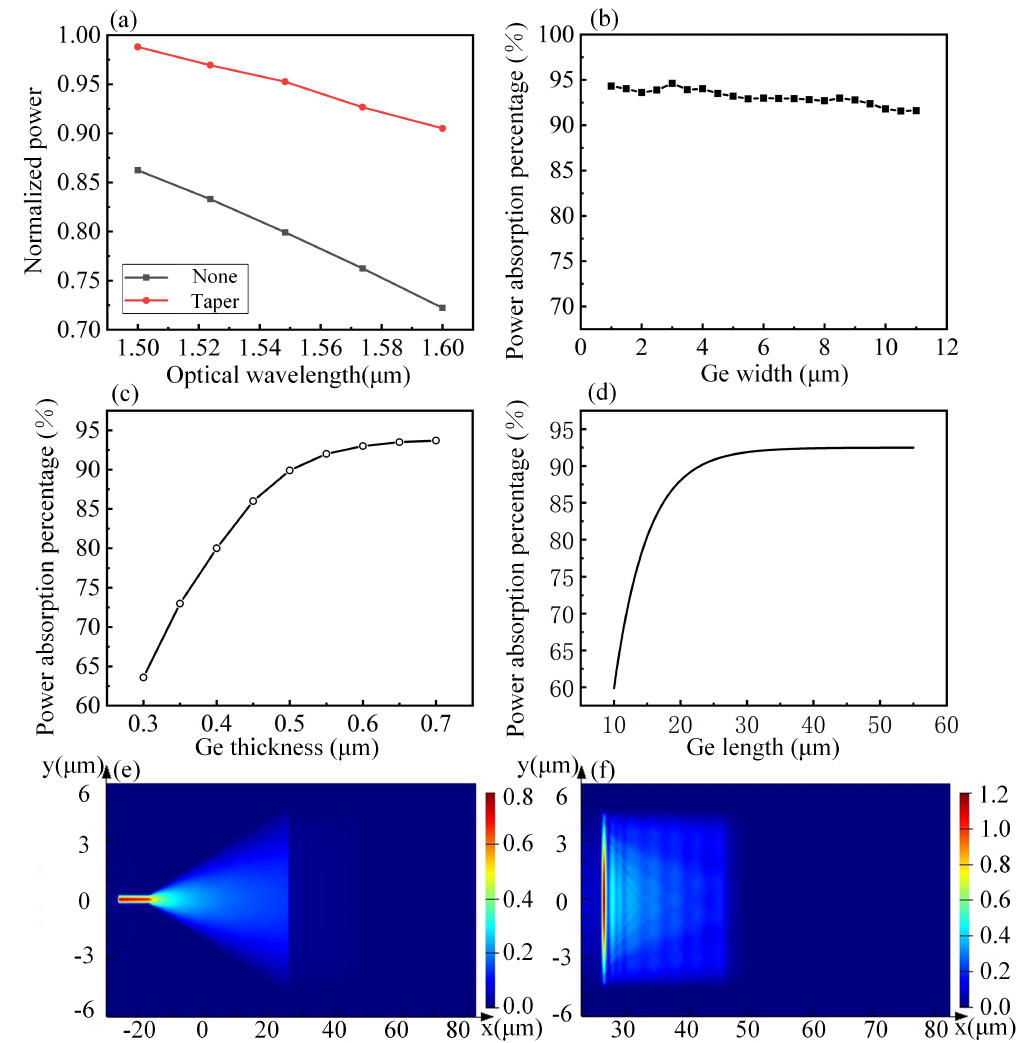
Figure 3. Structural simulation of Ge layer. ( a ) Normalized efficiency of energy transmission without taper structure and Si taper structure. ( b ) Variation curve of the absorption efficiency with Ge layer width. ( c ) Variation curve of the absorption efficiency with Ge layer thickness. ( d ) Variation curve of the absorption efficiency with Ge layer length. ( e ) Optical field distribution of the Si waveguide with a Si–Ge detector. ( f ) Optical field distribution of the Ge waveguide of the Si–Ge detector. The PD structure is designed using the L-edit software, including 10 layers of optical engraving. First layer formed with taper Si waveguide, the second and third layer forming P+ doped region and set up the positive electrode heavily doped P zone formation, the fourth layer forming epitaxial Ge area and is located in the center of Si waveguide, the fifth and sixth layers will form the N+ doped region and set up the negative electrode form heavily doped N area, the seventh and eighth layer metal contact hole filling metal tungsten formation, the tenth layer form a Bond Pad metal electrodes. After adding electrodes, the overall length of the PD is 500 µ m and the width is 300 µ